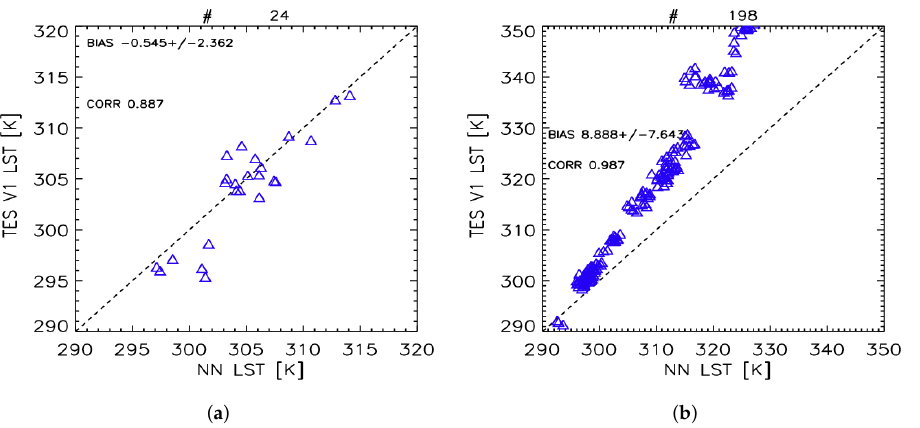
Figure 8. ( a ) LST retrieved with TES algorithm vs. LST from DLIM over 24 signatures (#24) of GANDART dataset not used for training. ( b ) LST retrieved with TES algorithm vs. LST from NN over the 198 signatures of the TASI2DART dataset